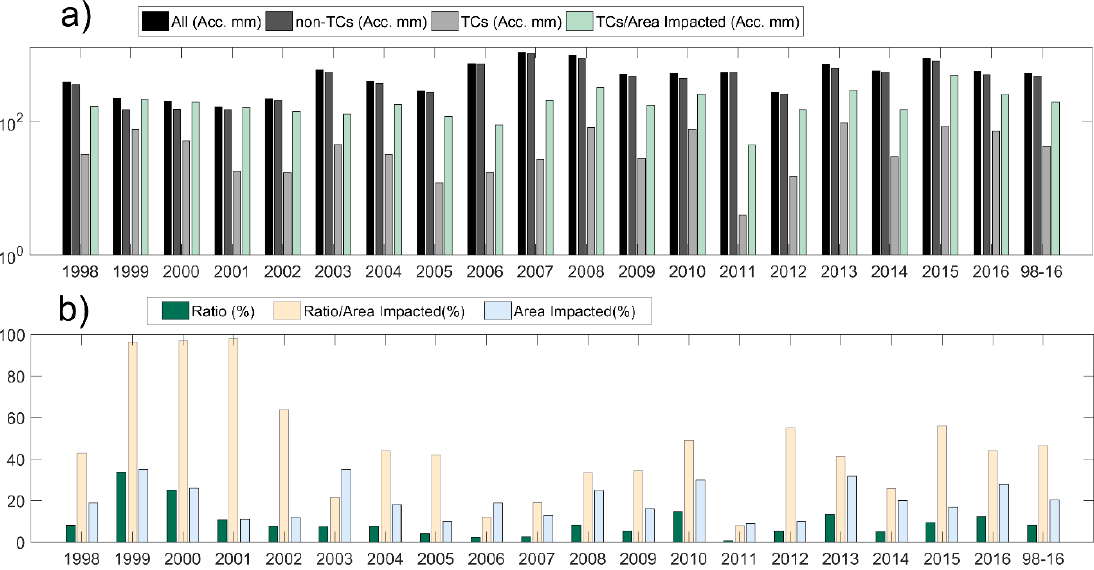
Figure 8. Yearly rainfall accumulation overland ( a ) for all rainfall events, TCs, and non-TCs ( b ) TC rainfall contribution to annual precipitation budget and the proportion of area impacted by TCs. The y-axis ( a ) represents a log scale for rainfall accumulation (mm).